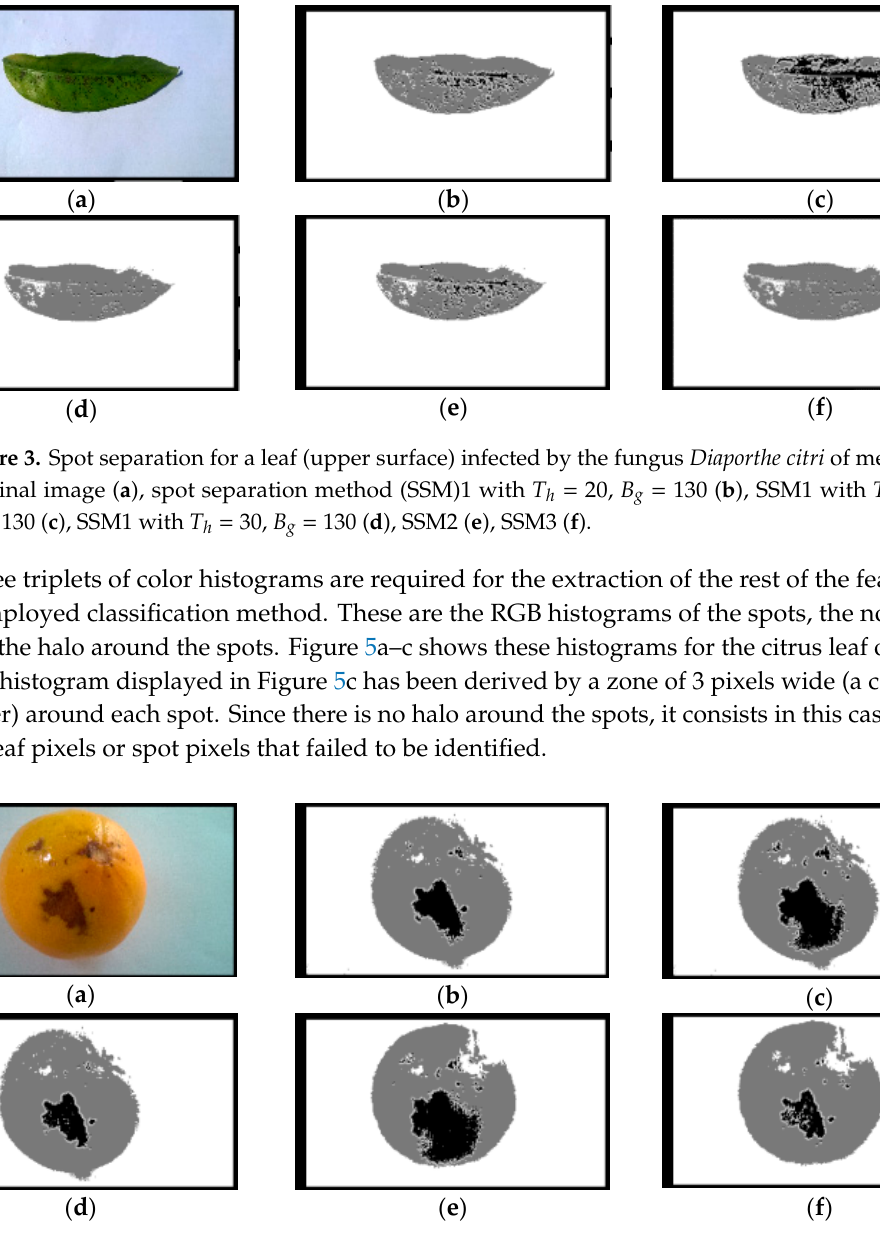
Figure 4. Spot separation for a fruit infected by the dematiaceous hyphomycete of Pseudocercospora . Original image ( a ), SSM1 with T h = 30, B g = 130 ( b ), SSM1 with T h = 20, B g = 130 ( c ), SSM1 with T h = 40, B g = 130 ( d ), SSM2 ( e ), SSM3 ( f ).